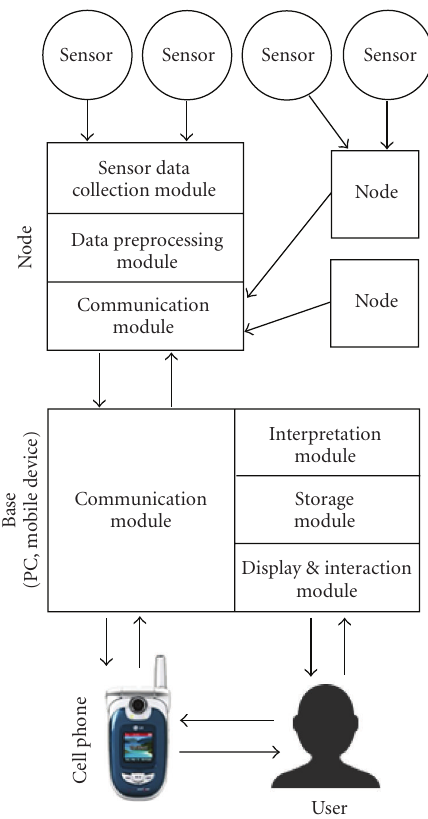
Figure 2: Diagram of the software